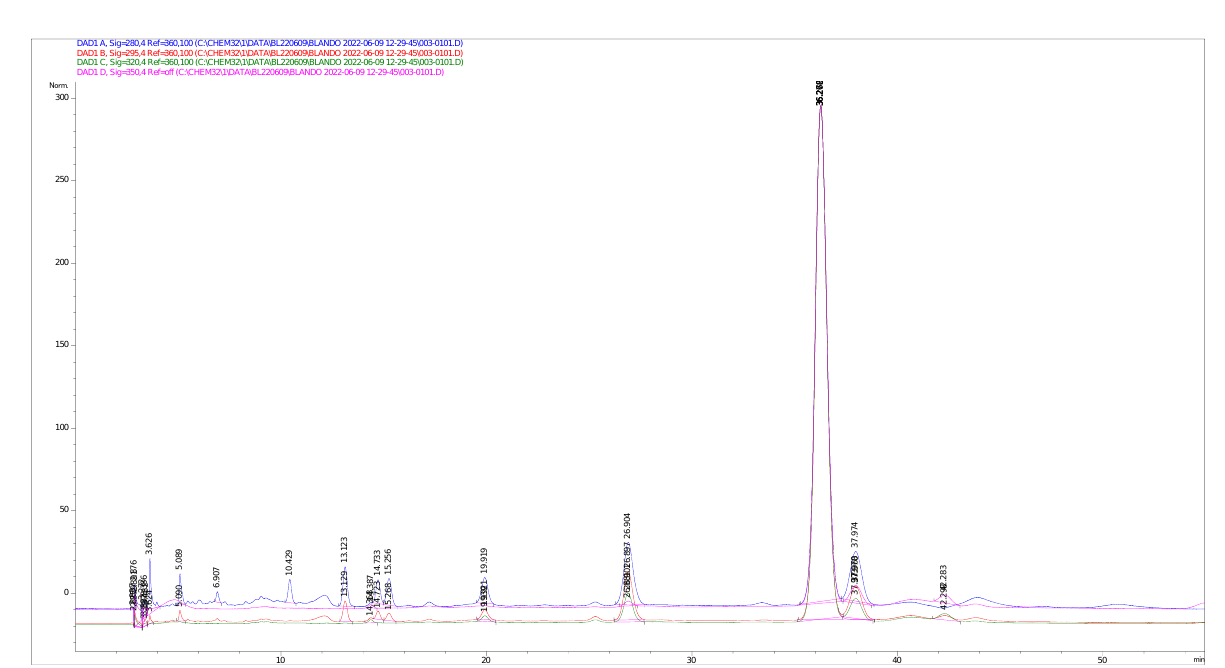
Figure A1. Representative chromatogram of phenolic acids identified on the basis of RT and absorp- tion spectra in the extracts of Svevo, Svevo HA, Faridur, Chifaa and lentil 6002/ILWL118/1-1.